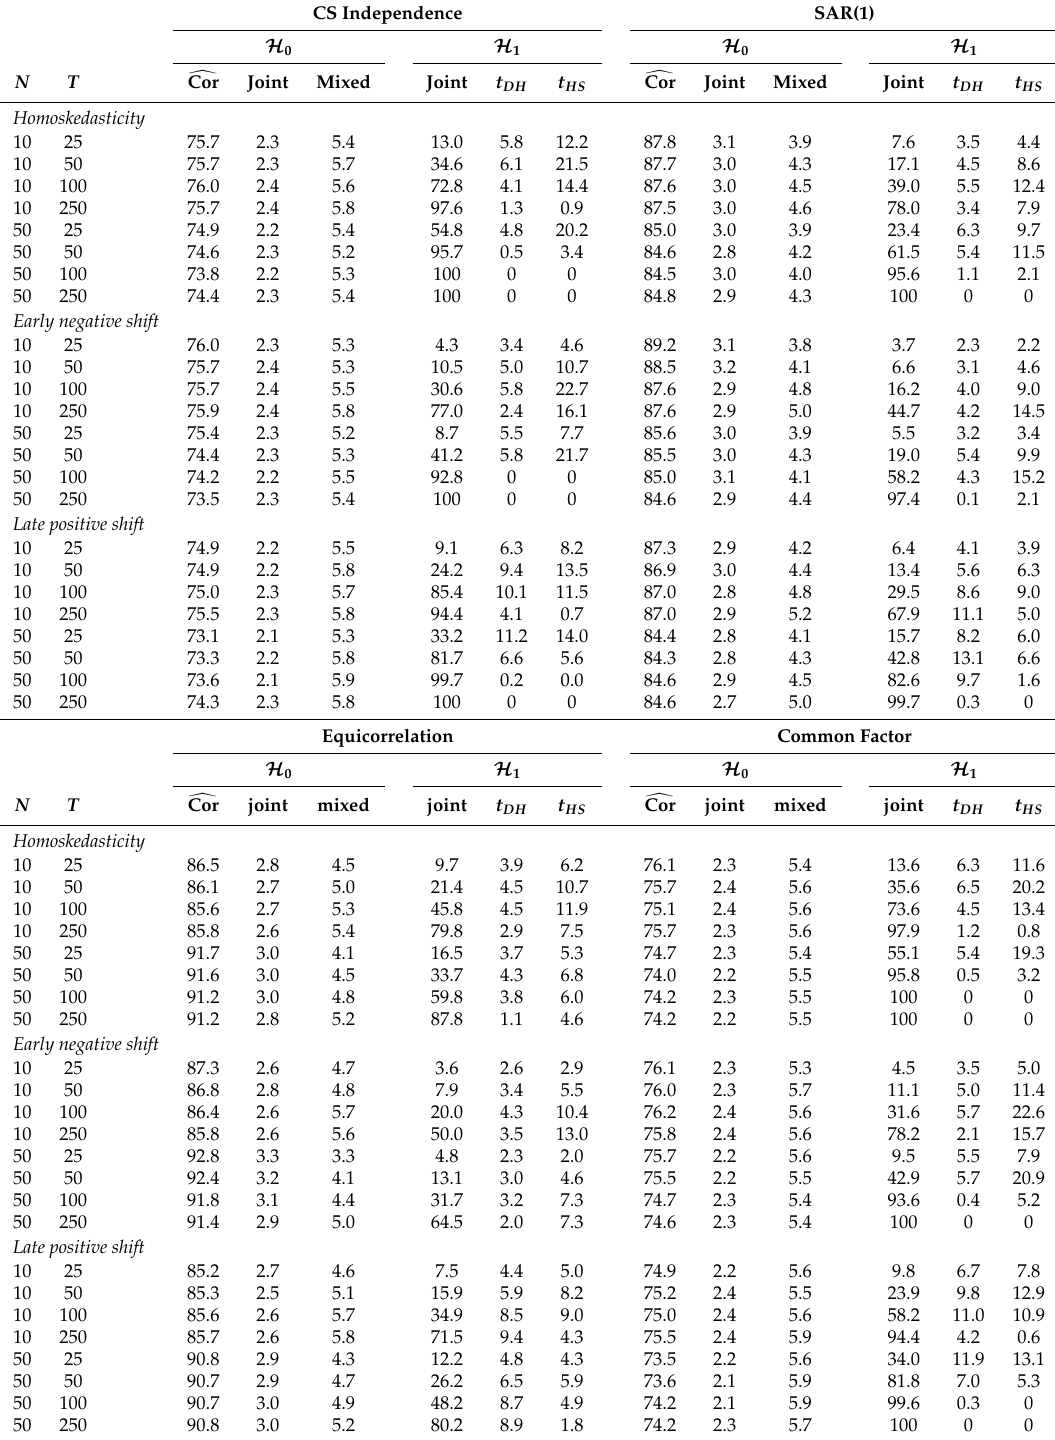
Table 1. Analysis of mixed signals: Columns t DH and t HS report proportions of only that test